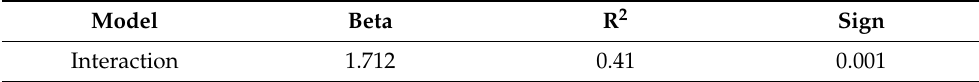
Table 11. Interaction—Moderate